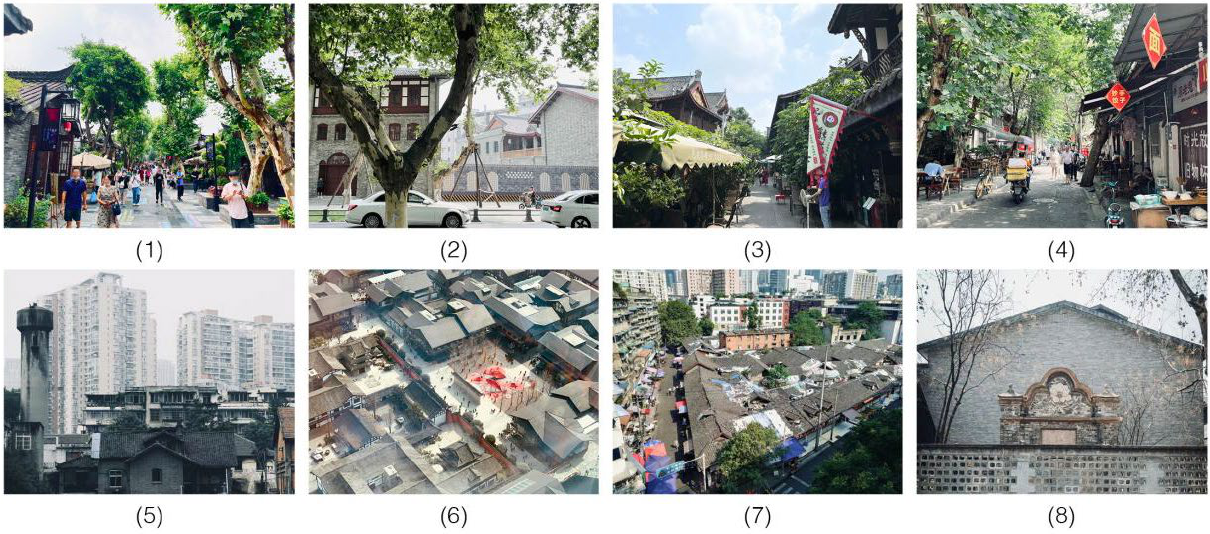
Figure 3. The cityscapes of the historic conservation areas. Source: Taken by the author. The numbers indicate the order of pictures order, which is consistent with the details provided in Figure 1 and Table 3. Table 3. Functional changes in the tourism sites.